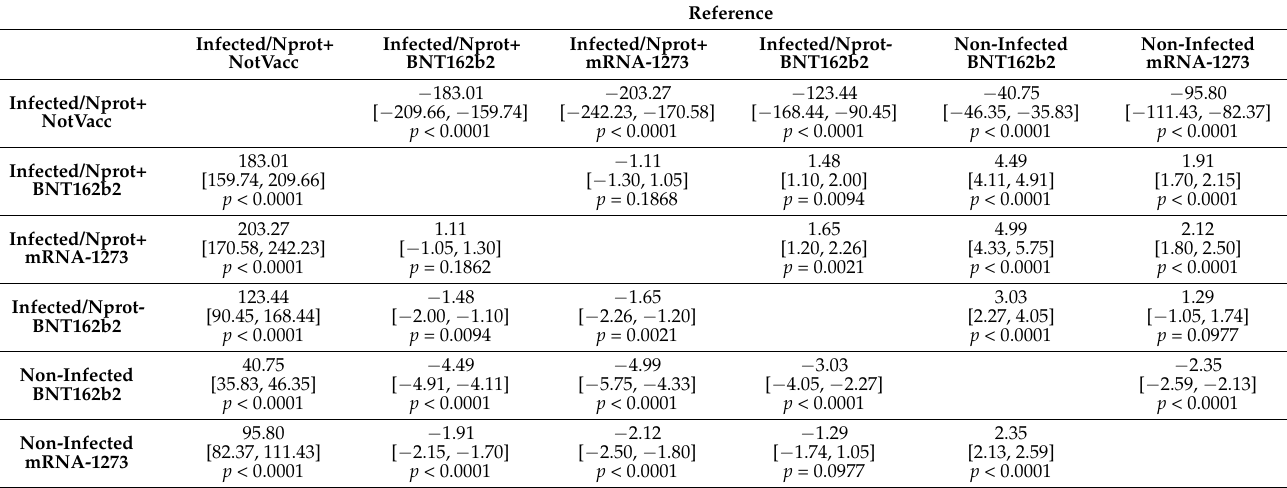
Table 2. Pairwise comparisons of antibody response against spike protein between subject groups. Reference